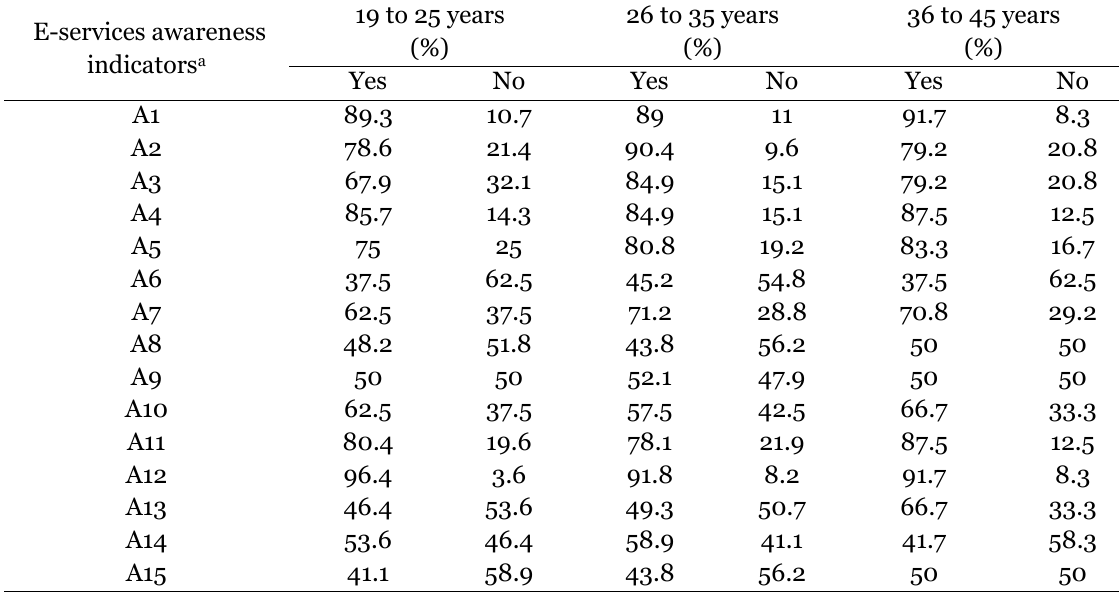
Learners’ Awareness of the University's e-Services by Age Group E-services